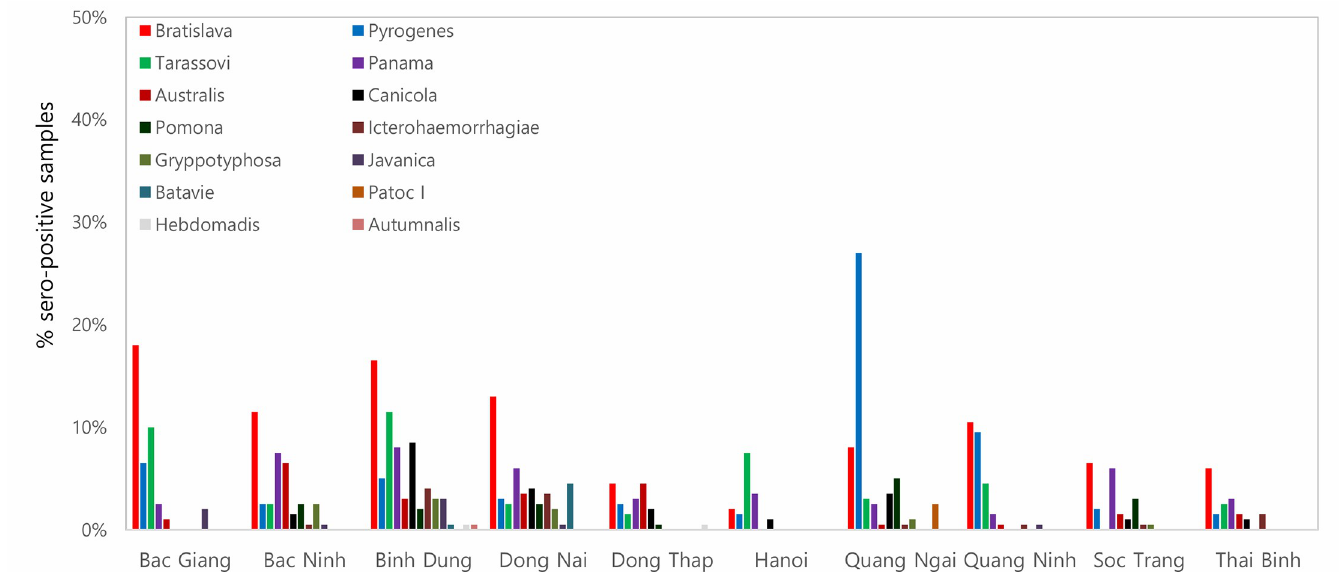
Fig 2. Proportion of sero-positive samples by serovar in each province using cutoff titer �